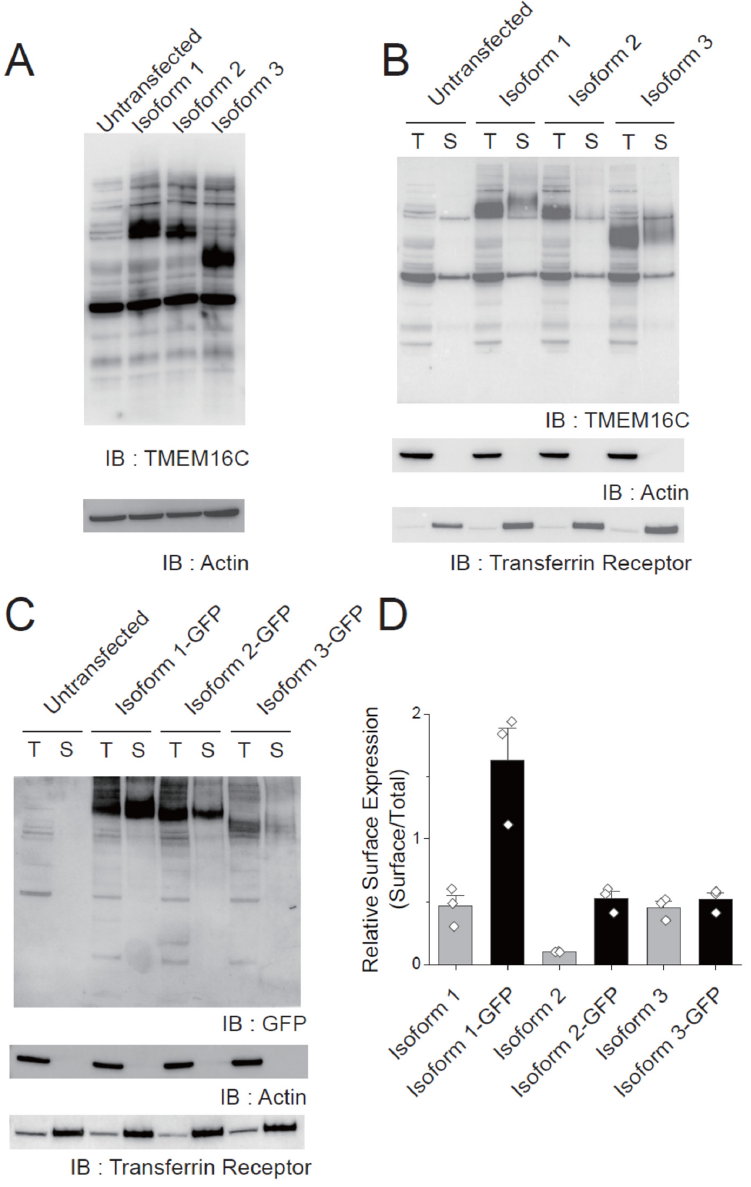
Figure 4. Surface expression of human TMEM16C isoforms. ( A ) Immunoblotting of cell lysates expressing human TMEM16C isoforms. Anti-TMEM16C (upper image) and anti-actin (lower image) antibodies were used. ( B ) Immunoblotting of surface biotinylated TMEM16C proteins. Surface fraction (S) samples were loaded at a 10-fold higher concentration than the total fraction (T). Anti- TMEM16C (upper image), anti-actin (middle image) and anti-transferrin receptor (lower image) antibodies were used to validate the biotinylation of surface-expressed proteins. ( C ) Immunoblotting of surface biotinylated GFP tagged TMEM16C proteins. ( D ) Quantification of relative surface expression of each isoform. Relative surface expression ratios were calculated by normalizing the band intensity of TMEM16C in the surface to the band intensity of TMEM16C in the total. Mean + SEM; n = 3 for each